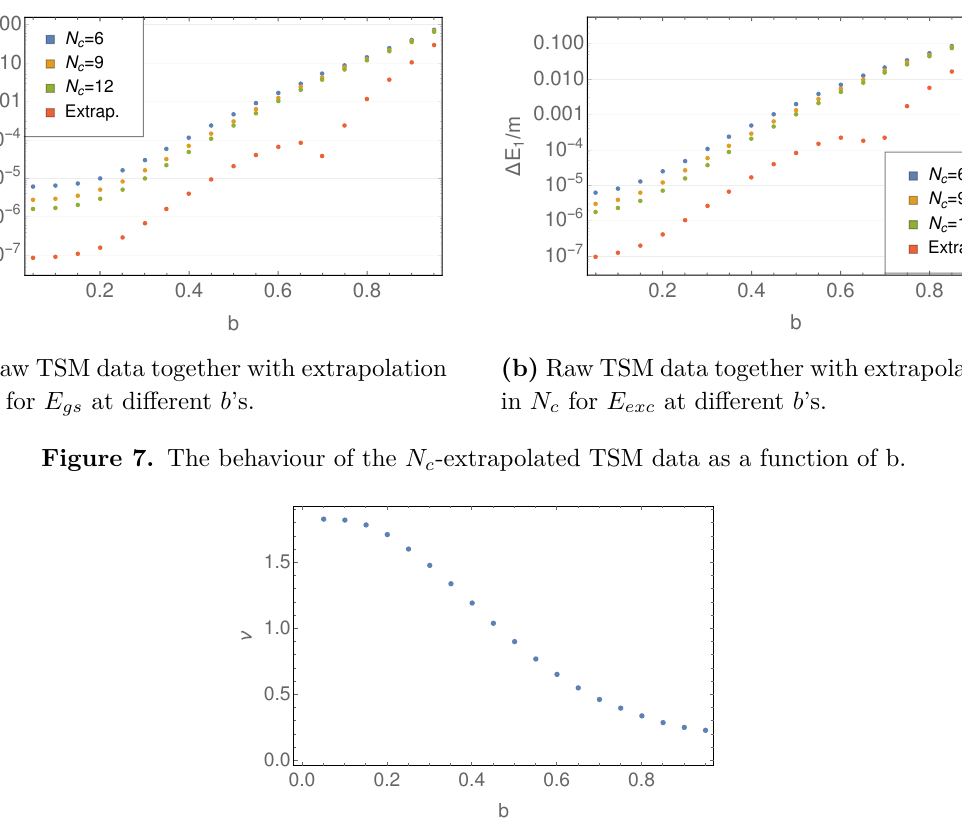
Figure 8. Power law exponents as a function of b for the extrapolation in N c given in eq. (5.1). also perform the same extrapolation in N